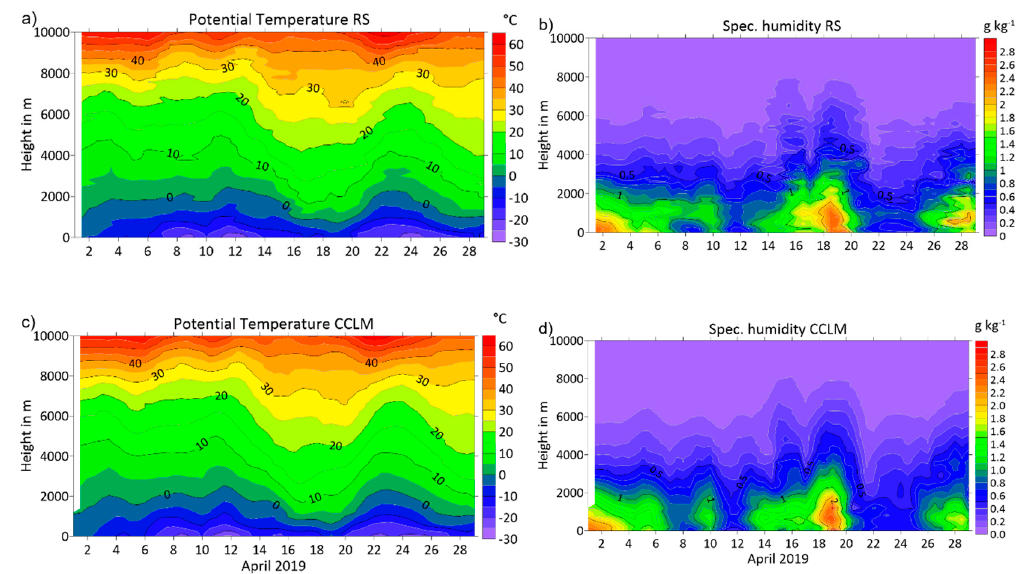
Figure 9. Time–height cross ‐ sections for the potential temperature from radiosondes ( a ) and CCLM ( c ) and for the specific humidity of the from radiosondes ( b ) and CCLM ( d ) for 1–29 April 2019.